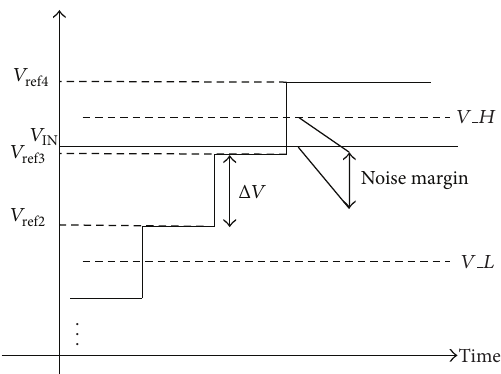
Figure 5: The noise margin definition of the proposed error correction